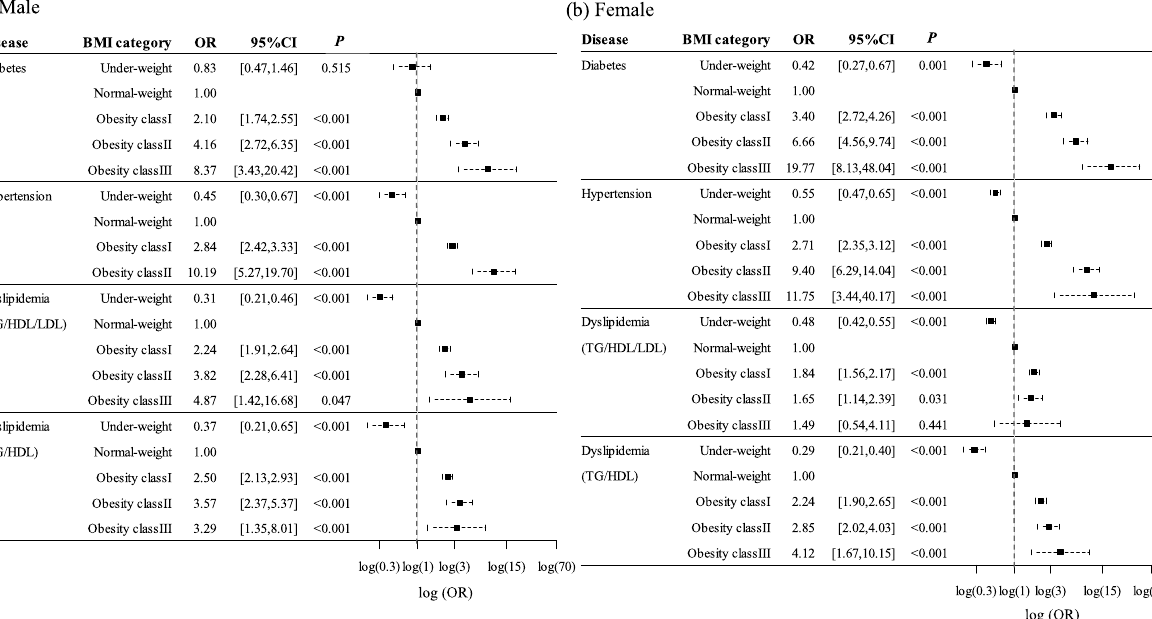
Figure 4. Adjusted OR and its 95% CI for diabetes, hypertension, and dyslipidemia in participants of each BMI category by gender with normal weight as the reference. Each OR was adjusted for smoking status and exercise habit. The horizontal axis represents the log-transformed adjusted OR. P -values were calculated in the comparison of the OR for each disease between normal-weight group (reference) and other groups by adjusting for multiplicity by Bonferroni’s correction. Dyslipidemia (TG/HDL/LDL) and dyslipidemia (TG/HDL) were defined in the